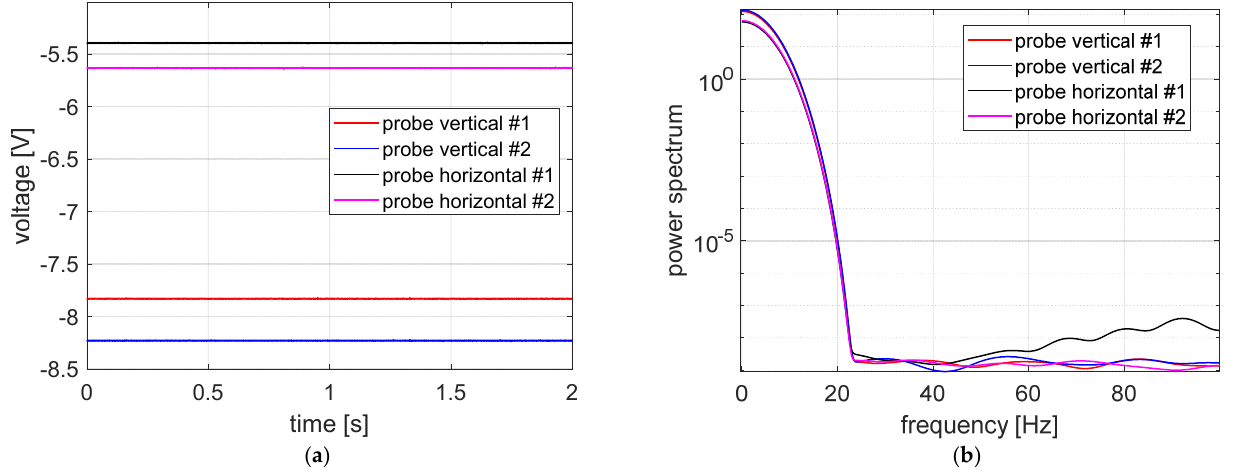
Figure 9. Measurement signals recorded with both magnetic bearings and measuring sensors pow- ered on: ( a ) time courses, ( b ) signal power spectrum.